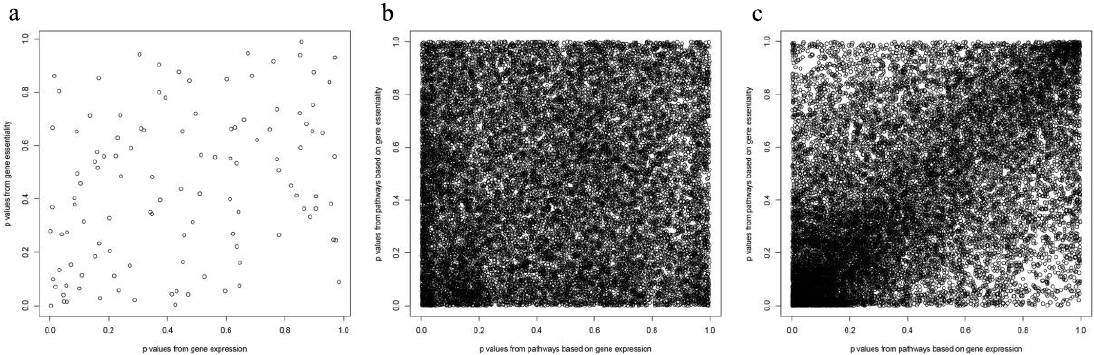
Figure 6. Scatter plot of the p -values from gene expression and essentiality. The more points in the main diagonal, the more correlation between the 2 groups. ( a – c ) Feature groups 1–3.